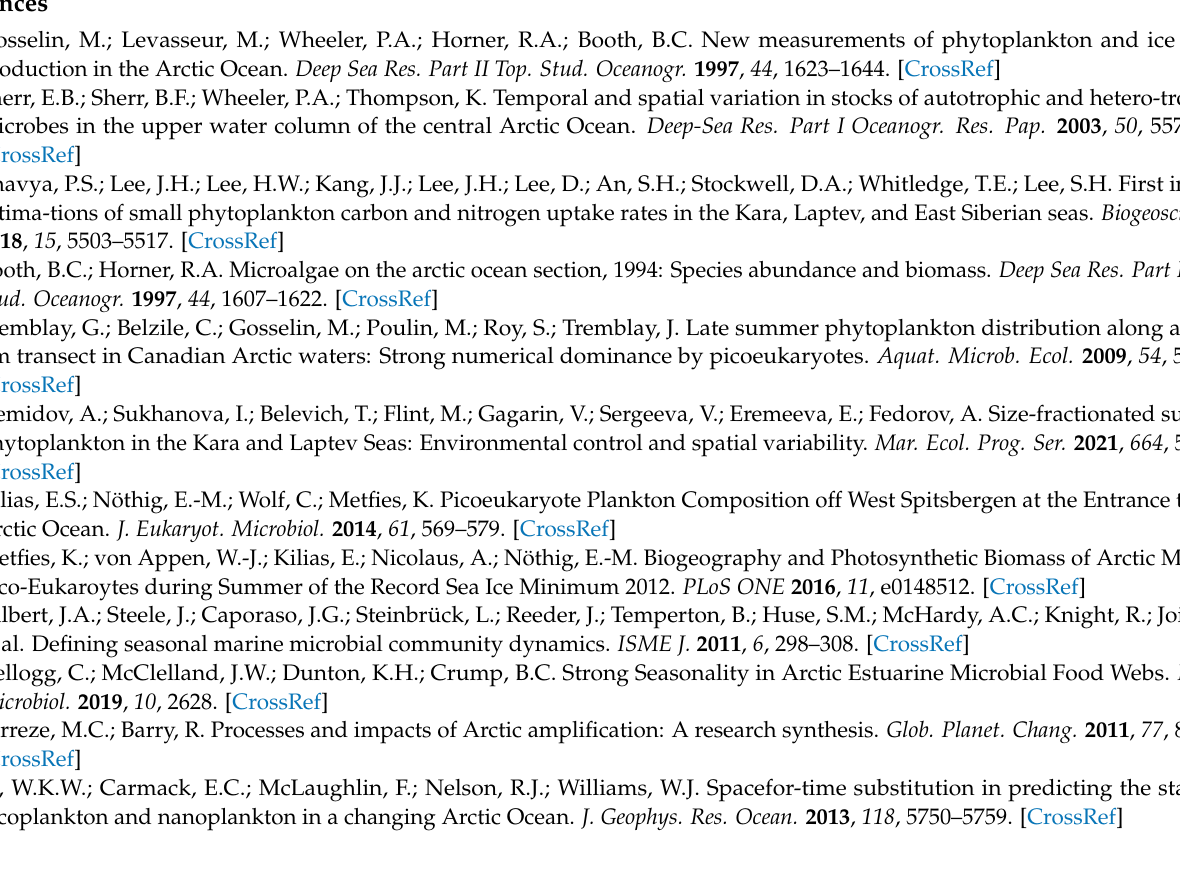
taxonomy against PR2, Table S2: Fasta file of picoplankton ASVs revealed during the sediment trap